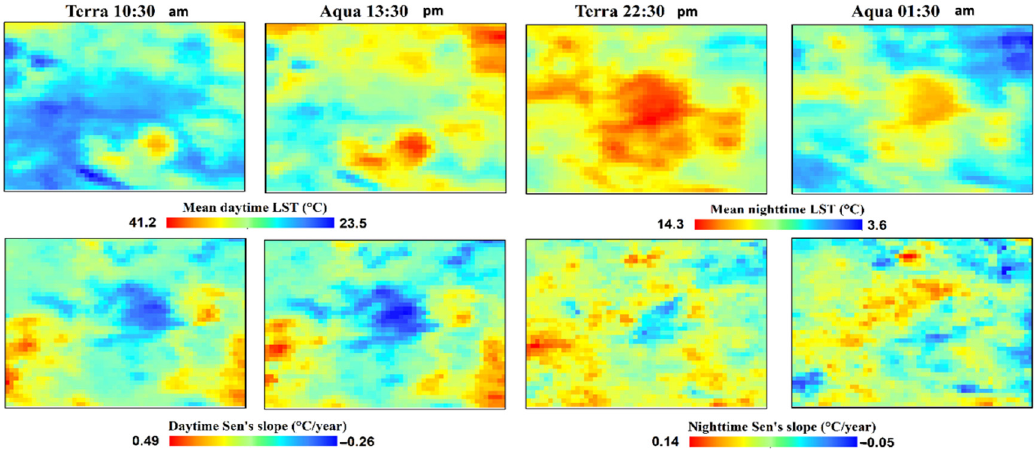
Figure 3. Spatial variation of mean annual LST (average over 2003–2019) during daytime (Terra 10:30 a.m. and Aqua 13:30 p.m.) and nighttime (Terra 22:30 p.m. and Aqua 01:30 a.m.) in first row and the value of Sen’s slop for the corresponding LST images in the second row. Table 1. Annual, seasonal (summer and winter), and monthly (January-December) mean LST from 2003 to 2019 for urban and non-urban pixels at daytime (10:30 a.m. and 13:30 p.m.) and nighttime (22:30 p.m. and 01:30 a.m.). Terra 10:30 a.m. Aqua 13:30 p.m. Terra 22:30 p.m. Aqua 01:30